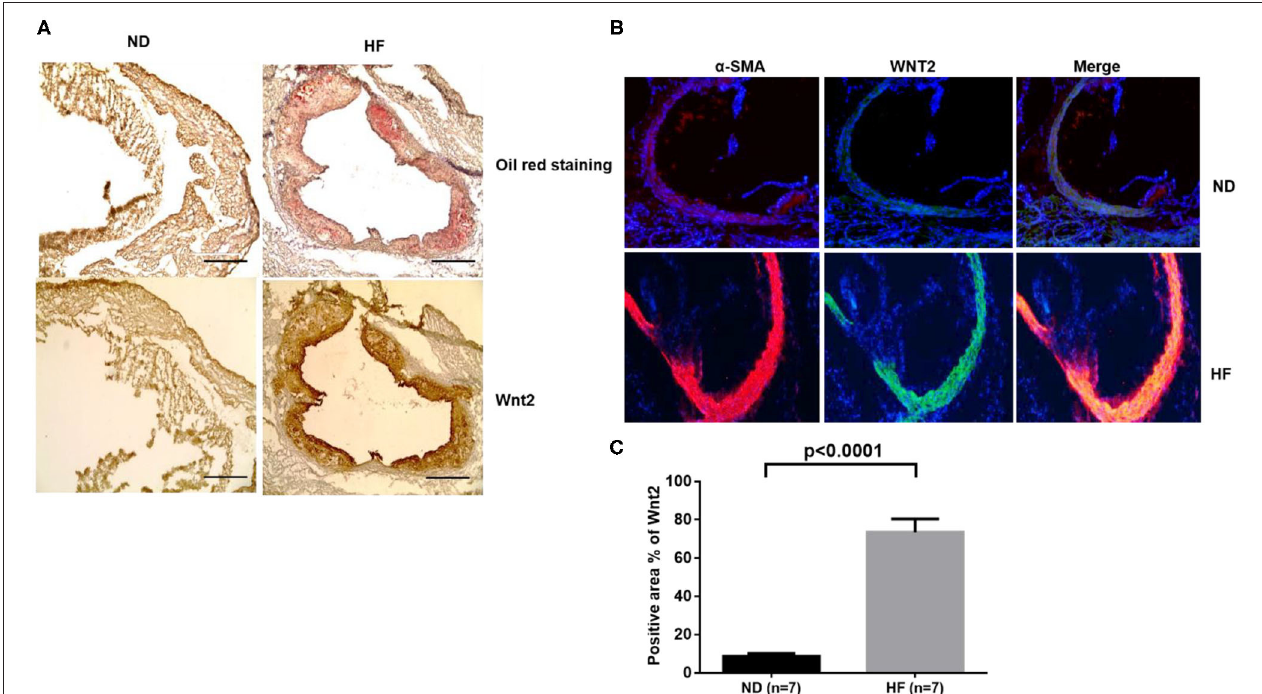
FIGURE 5 | Wnt2 is involved in the atherosclerotic lesion development. Upper panels (A) : Oil Red O staining of atherosclerotic lesions in the aortic root at the level of the aortic valves of LDLR − / − mice fed on a normal diet (ND) and a high-fat (HF) diet. Lower panels: Immunohistochemistry staining of Wnt2 protein. Magnification is x10, scale bars = 400 µ m. (B) Immunostaining for α -SMA (Red) and Wnt2 (Green) expressions in atherosclerotic lesions derived from the aortic valves of LDLR − / − mice fed on a normal diet (ND) and a high-fat (HF) diet. (C) Quantification for the Wnt2 staining area in α -SMA-positive atherosclerotic lesions derived from the aorta. Each value represents the mean ± SD. n =